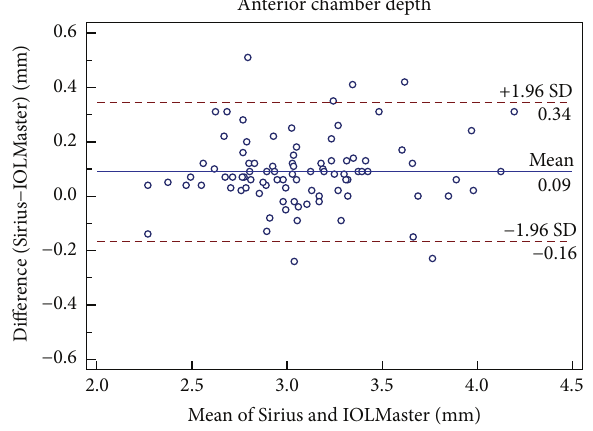
Figure 1: Bland-Altman plots of agreement of anterior chamber depth measurements taken with the Sirius Scheimpflug/Placido photography-based topography system and IOLMaster partial coherence interferometry. The solid line indicates the mean differ- ence (bias). The upper and lower lines represent the 95% limits of agreement.